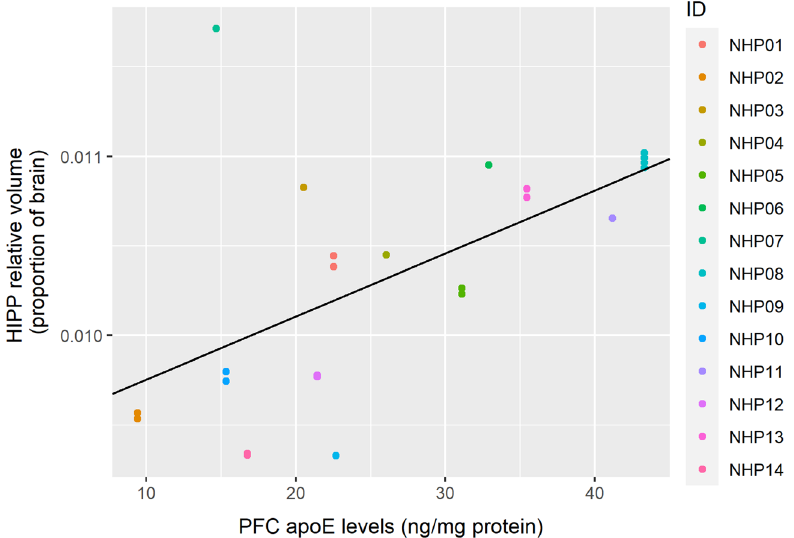
Figure 7. Levels of apoE in the PFC positively predicts relative HIPP volume. This is the opposite effect of the AMYG apoE levels on relative HIPP volume. The figure shows results from a GEE model using PFC apoE levels as the sole predictor. Individual macaque IDs are distinctly colored.